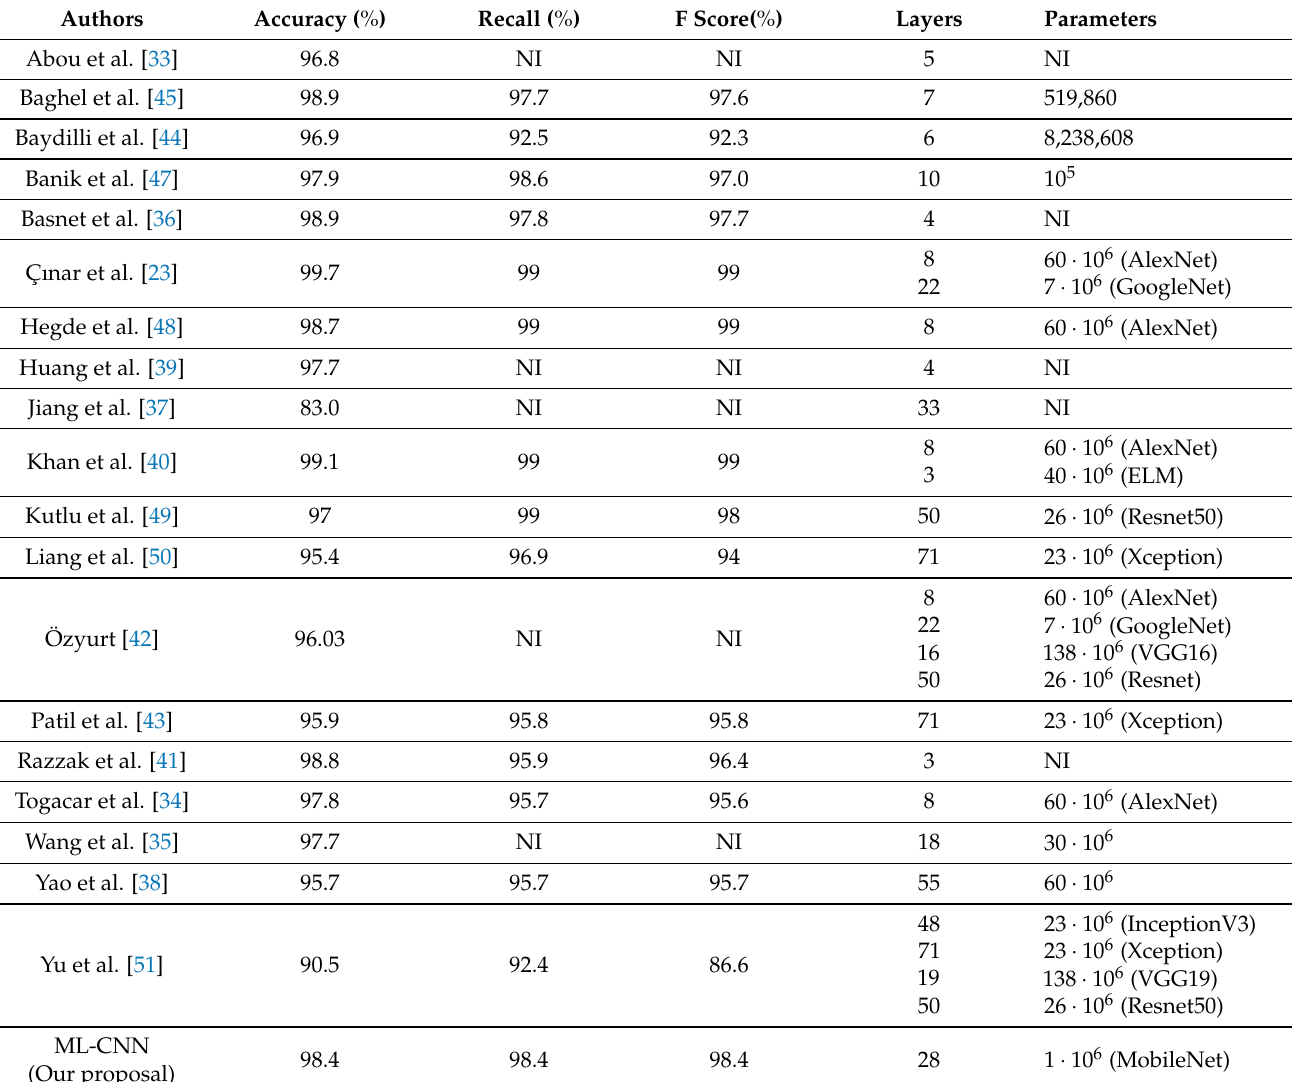
Table 4. Comparison of WBC classification results with models in the sate of the art. (NI denotes not